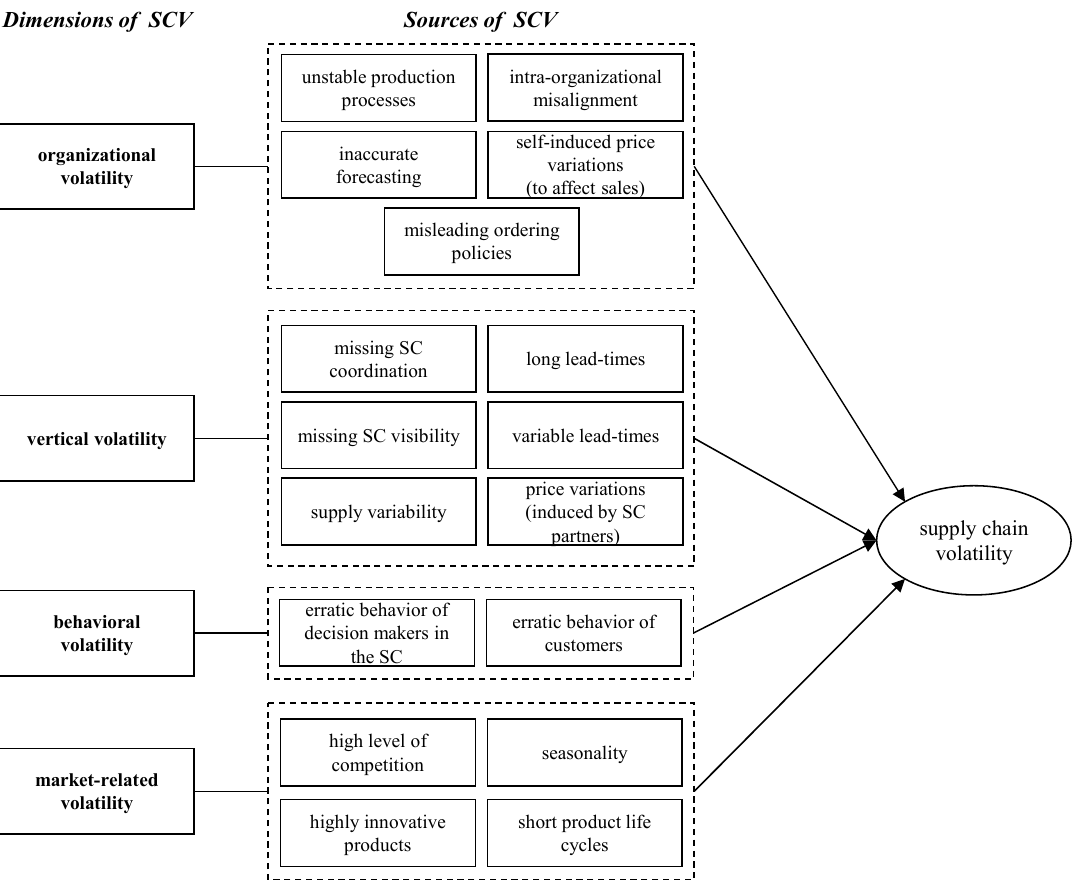
Figure 1. Adapted framework of dimensions and sources of SCV .